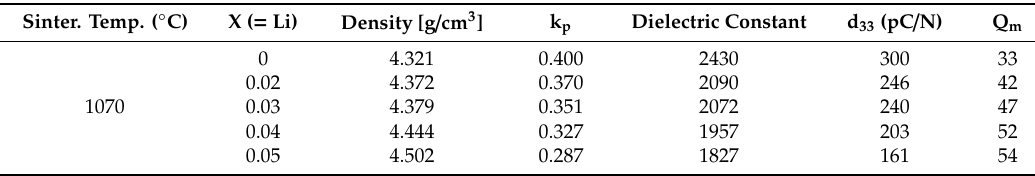
Table 1. Physical properties of specimens with x.